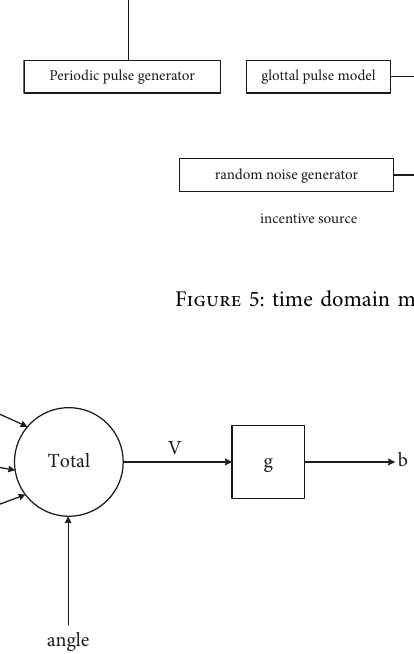
Figure 6: Neuron